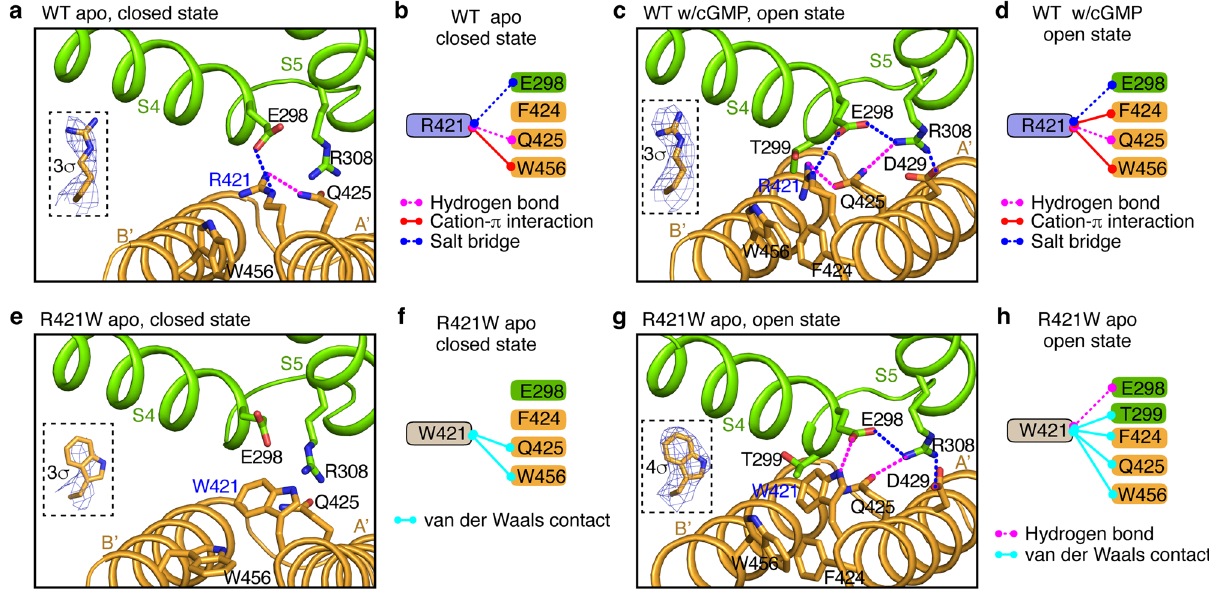
Fig. 7 Interaction networks of R421 and W421. a , c , e , g Close-up views of local structures and amino acids near R421 in apo closed-state WT TAX-4 ( a ) or cGMP-bound open-state WT TAX-4 ( c ), or near W421 in apo closed-state TAX-4_R421W ( e ) or apo open-state TAX-4_R421W ( g ). Insets show the density maps of R421 or W421 side chains and the corresponding contour levels. b , d , f , h Diagram of interactions of R421 or W421 with nearby amino acids in channels and states corresponding to those depicted in a , c , e and g , respectively.